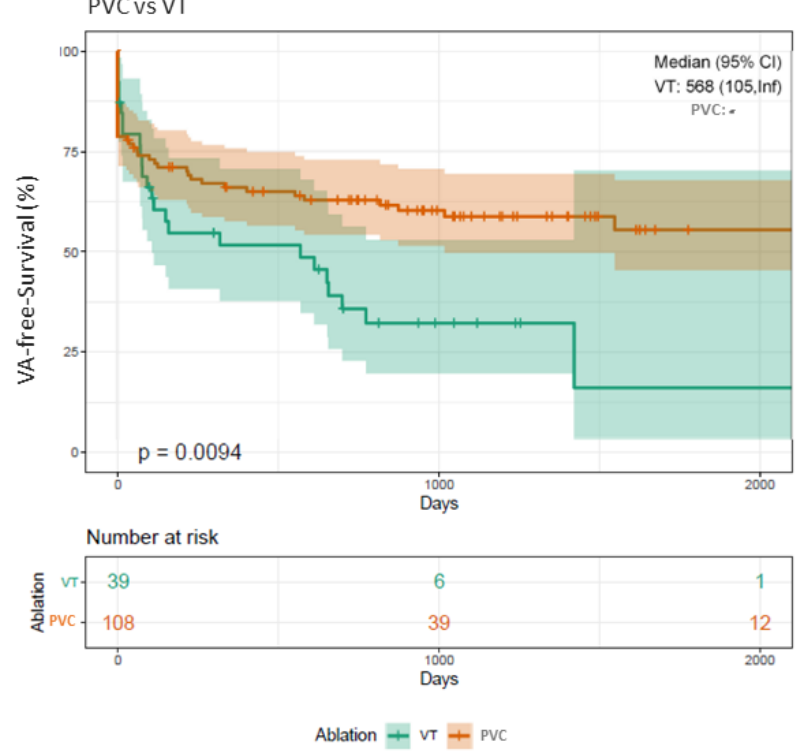
Figure 1. Kaplan–Meier plot on freedom from VA recurrence in patients undergoing RMN VT ablation compared to PVC ablation. Patients undergoing RMN ablation for VT present with a significantly higher recurrence rate of VA in the FU in comparison to patients treated for PVC (Log-rank p -value = 0.009*). VA, ventricular arrhythmia; VT, ventricular tachycardia; PVC, premature ventricular contractions; RMN, remote magnetic navigation; FU, follow-up.